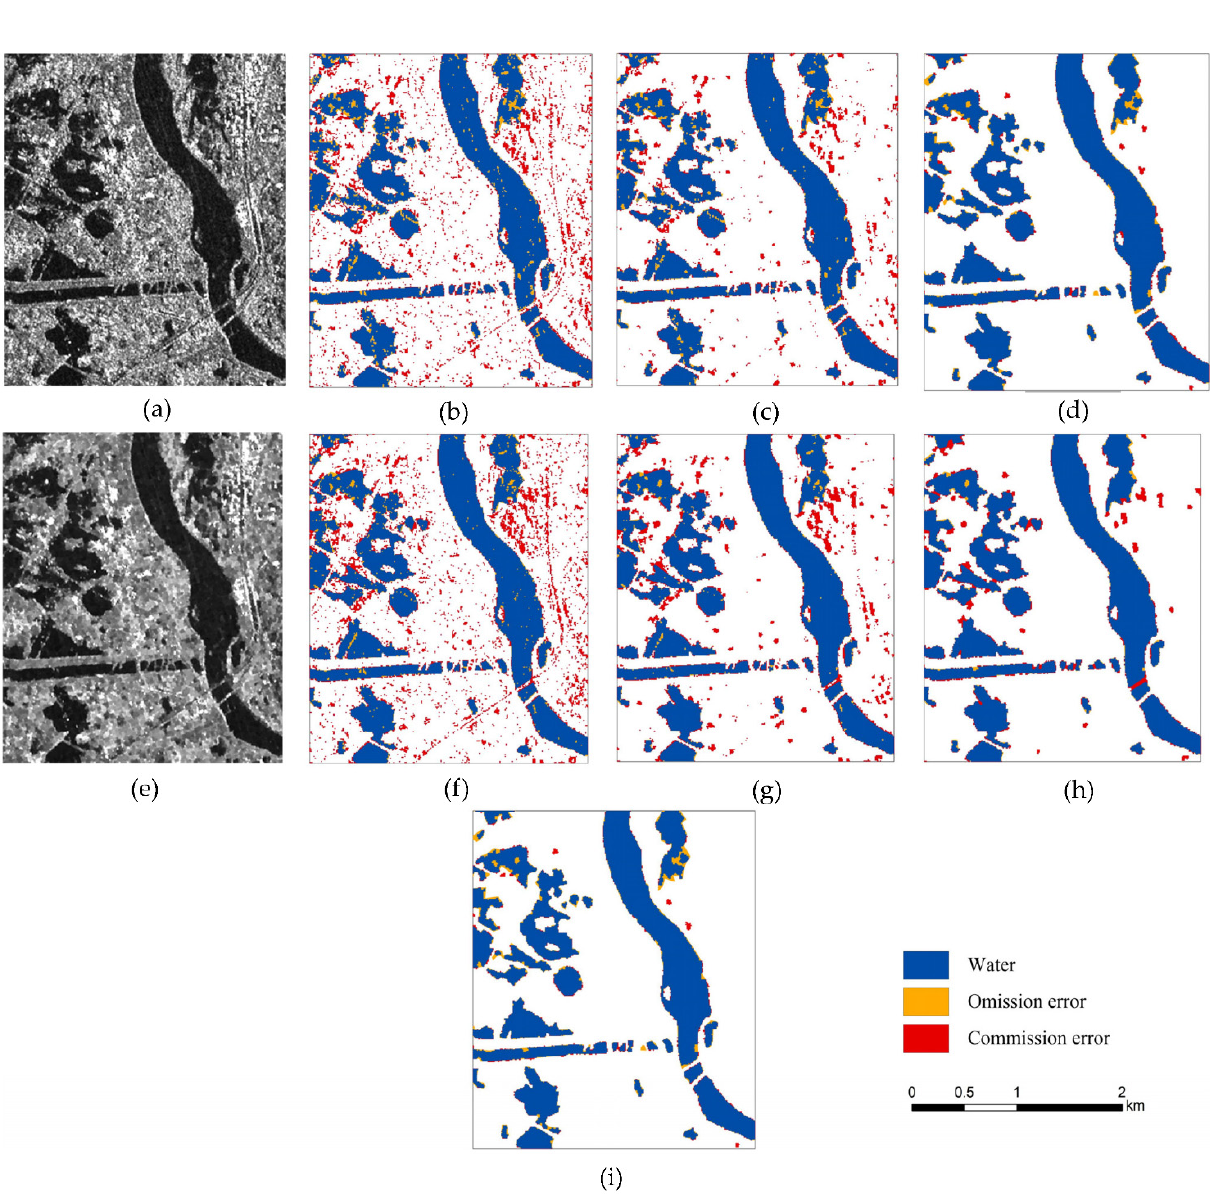
Figure 12. ( a ) HH polarimetric SAR image. ( b – d ) are the water maps derived from ( a ), which are processed by KI, refined Lee filter + KI, and refined Lee + KI-MRF-SA respectively. ( e ) HV polarimetric SAR image. ( f – h ) are the water maps derived from ( e ), which are processed by KI, refined Lee filter + KI, and refined Lee + KI-MRF-SA respectively. ( i ) The intersection of ( d , h